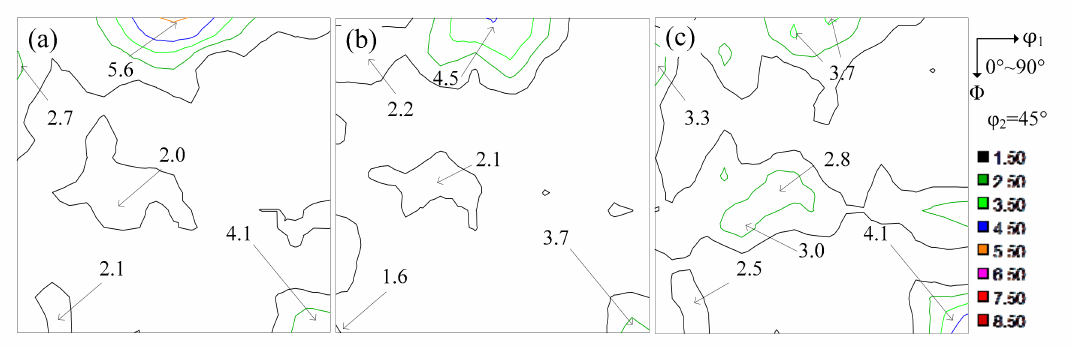
Figure 10. The annealing macro-texture of 0.35 mm strip-cast non-oriented silicon steel: ( a ) S = 0; ( b ) S = 3/4; ( c ) S = 1/2.